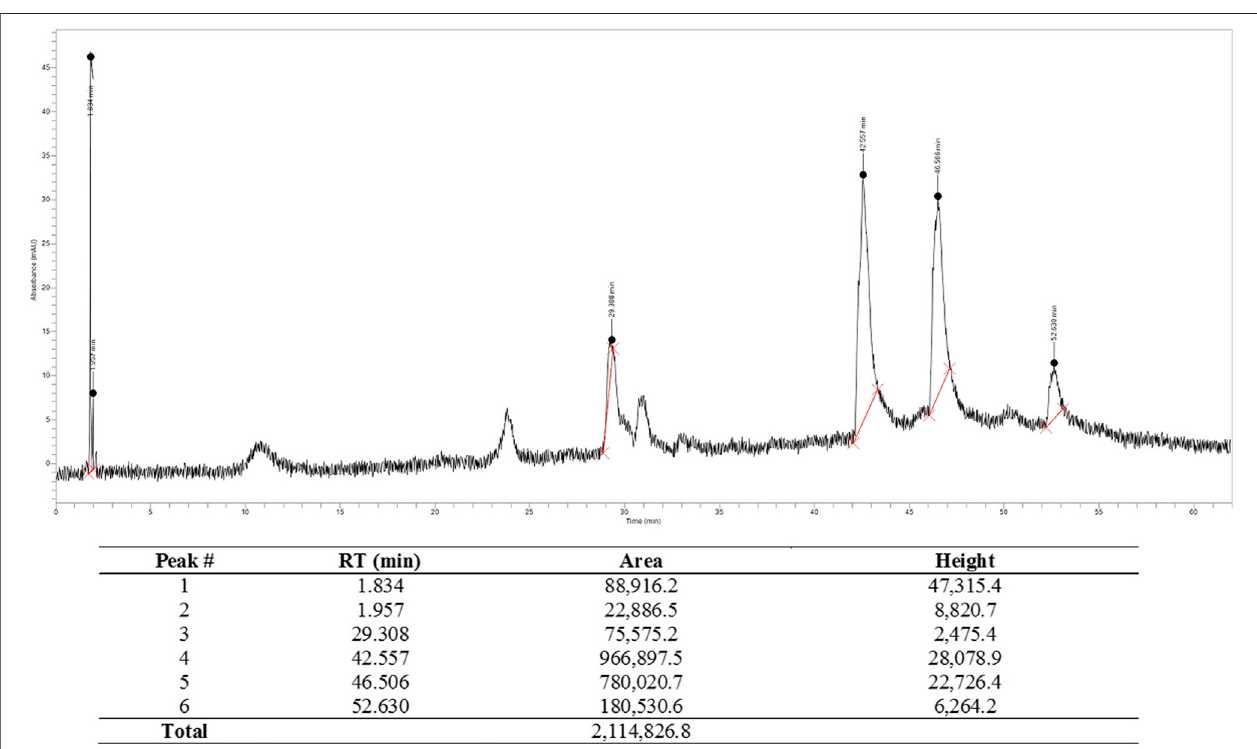
FIGURE 1 | High performance liquid chromatography chromatogram of SNE monitored at 315